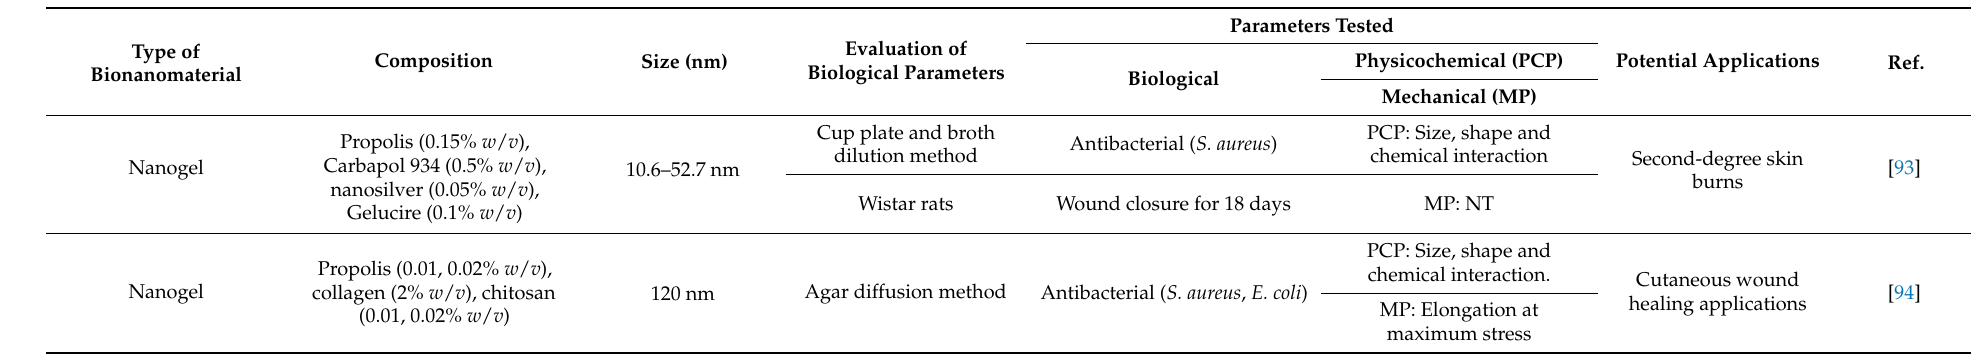
Table 2. Bionanomaterials based on propolis. Type of bionanomaterial, composition, size, evaluation models, parameters tested (biological, physicochemical and mechanical), potential applications and